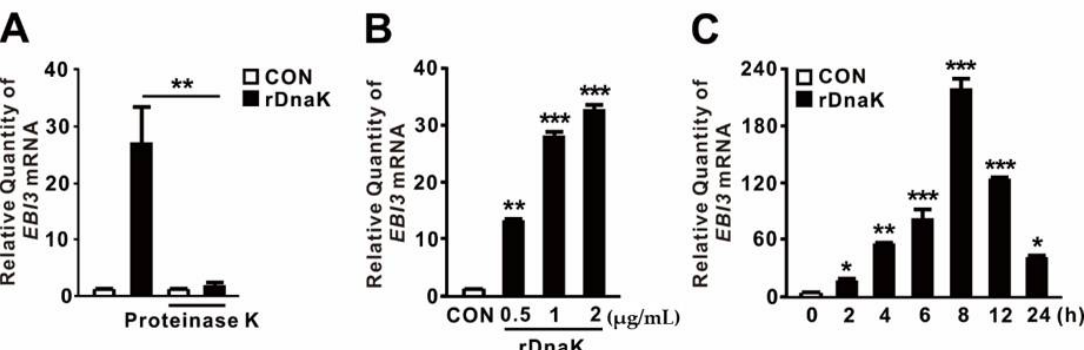
Figure 2. P. aeruginosa -derived DnaK induces expression of EBI3 . ( A ) dTHP-1 cells were treated for 4 h with recombinant P. aeruginosa DnaK (rDnaK; 0.5 µ g / mL) pretreated with Triton X-114. Treatment with proteinase K (20 µ g / mL) was performed for 1 h. ( B , C ) dTHP-1 cells were treated with the indicated concentrations of rDnaK for 4 h ( B ) and 0.5 µ g / mL rDnaK for the indicated times ( C ). After treatment, EBI3 mRNA levels were quantified by qRT-PCR. Data are expressed as means ± SD ( n = 3). *, p < 0.05; **, p < 0.01; ***, p < 0.001 vs. no treatment with proteinase K ( A ), CON ( B , C